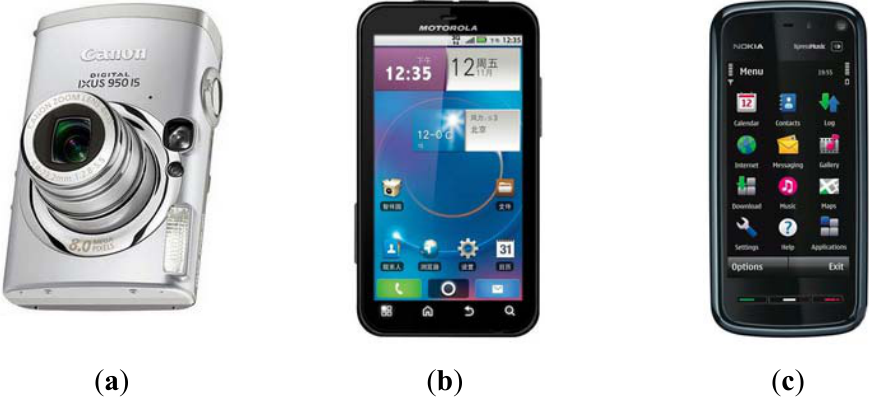
Figure 1. Three devices used for PRADD palmprint image collection: ( a ) the Canon IXUS 950 IS (C950) digital camera; ( b ) the Motorola ME525 (M525) smart-phone; ( c ) the Nokia 5800 XpressMusic (N5800) smart-phone.